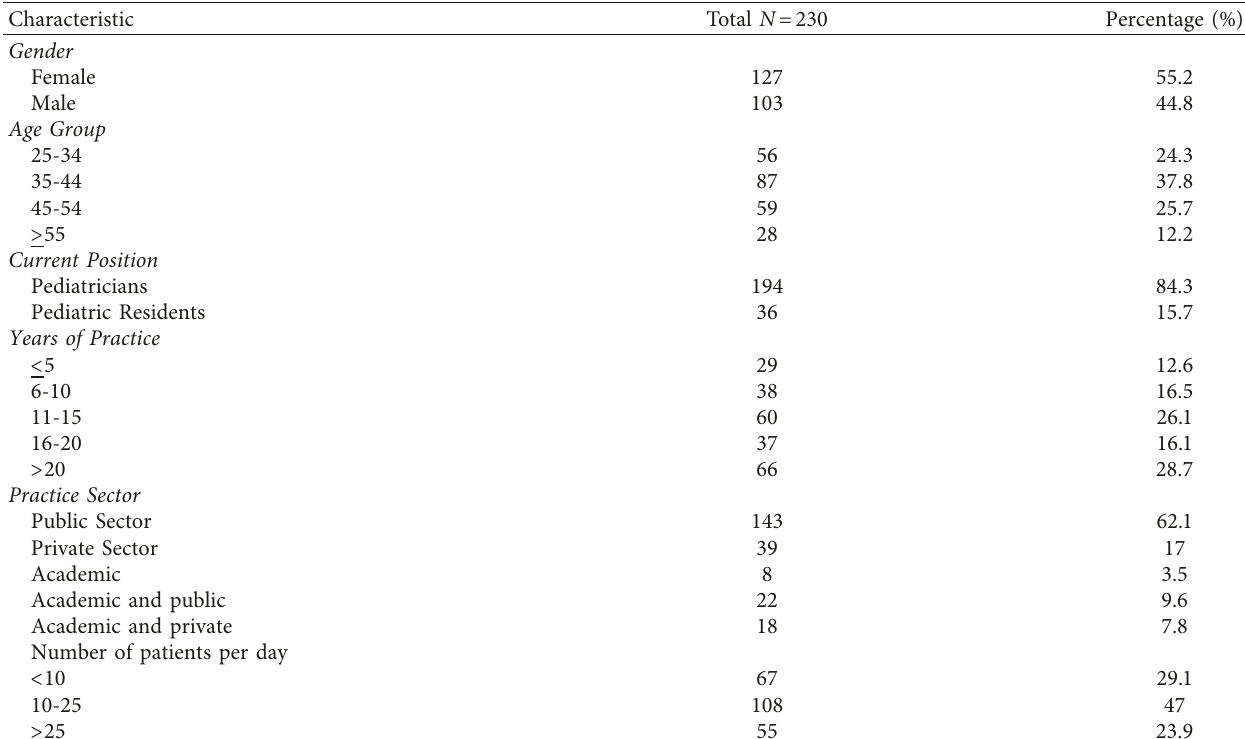
Table 1: Socio-demographic characteristics of the study